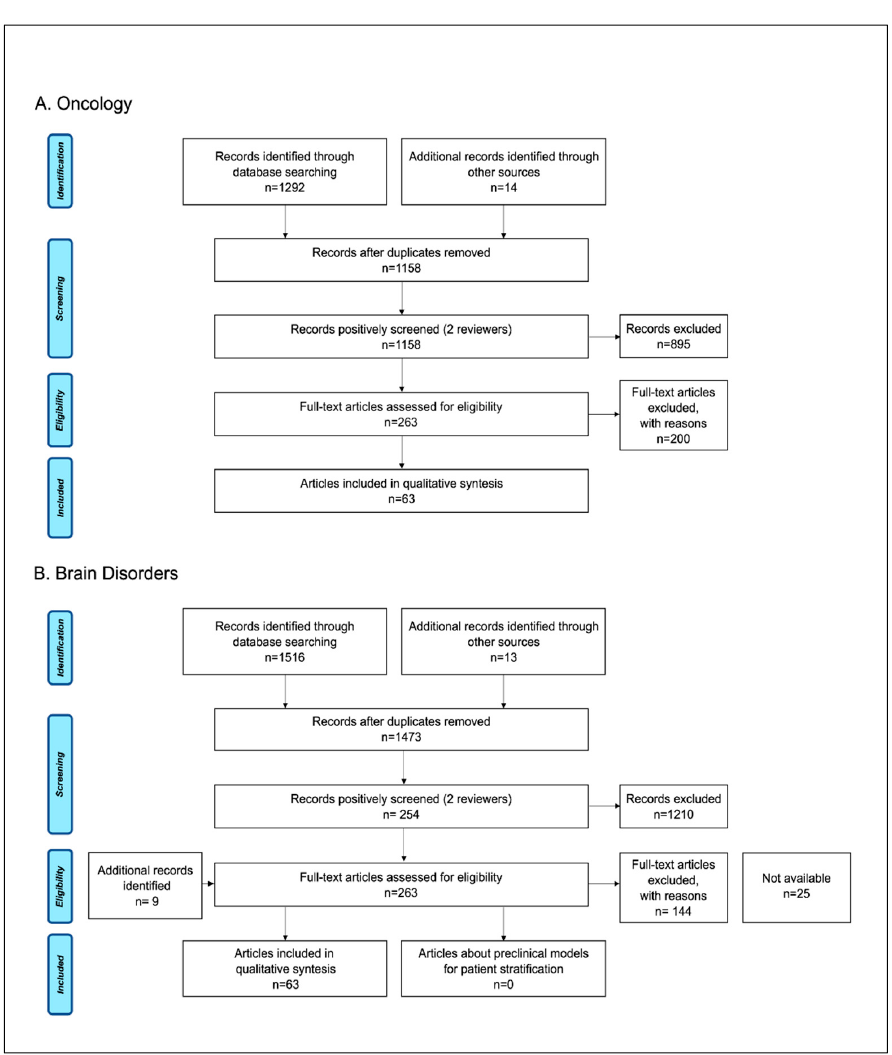
Figure 2. Study selection flow diagram: PRISMA flow-chart of data collection process for the ( A ) oncology and ( B ) brain disorders literature searches.